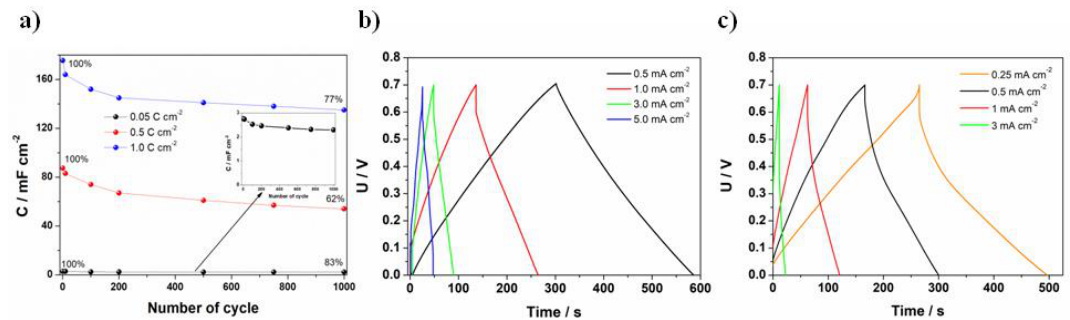
Figure 7. ( a )The capacitance vs. number of the cycle plot recorded for a symmetric supercapacitor FTO/PANI/WO 3 ; 0.05, 0.5 and 1 C cm −2 stands for charge consumed during electrodeposition of one electrode material; charge and discharge curves at different current densities applied for ( b ) PANI/WO 3 symmetric supercapacitor and ( c ) PANI/Cl symmetric supercapacitor.